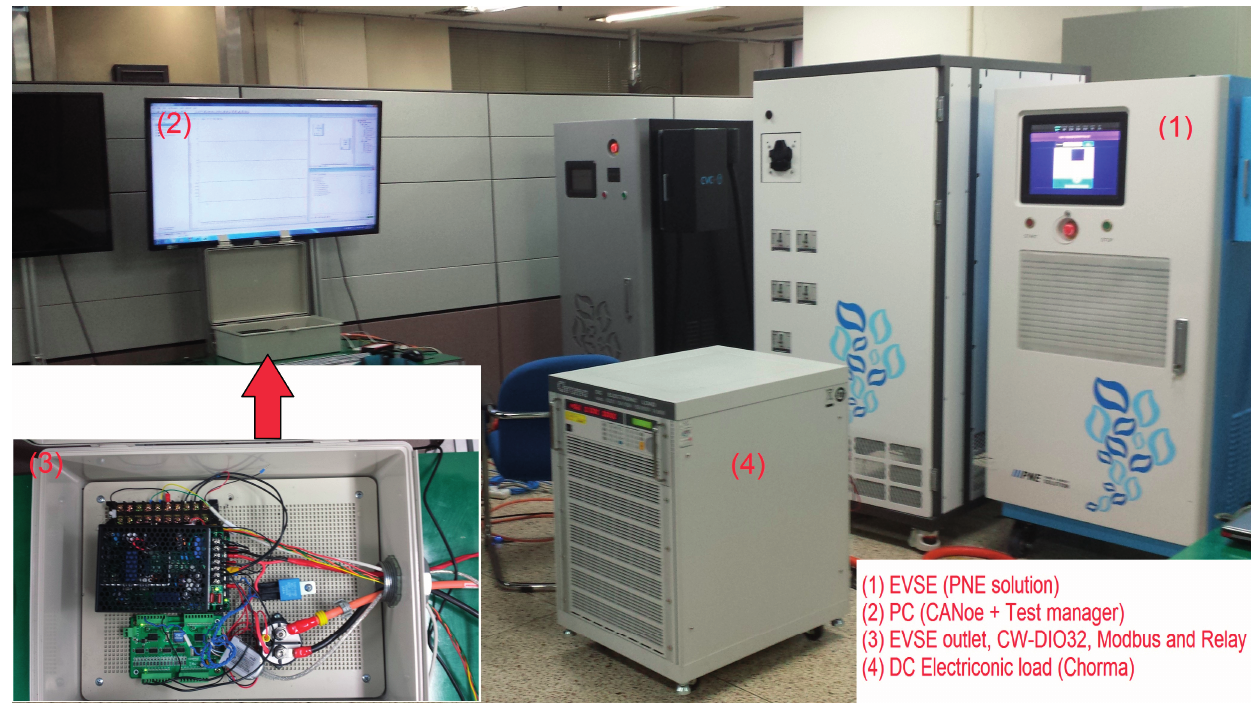
Figure 4. The testing system components.